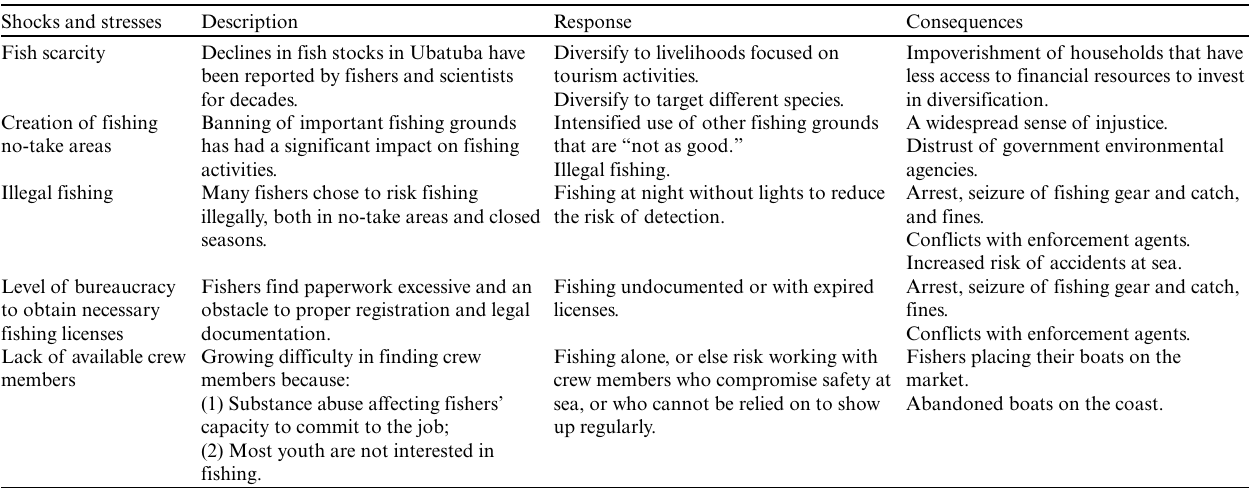
Table 1 . Shocks and stresses described by participants, responses and consequences for